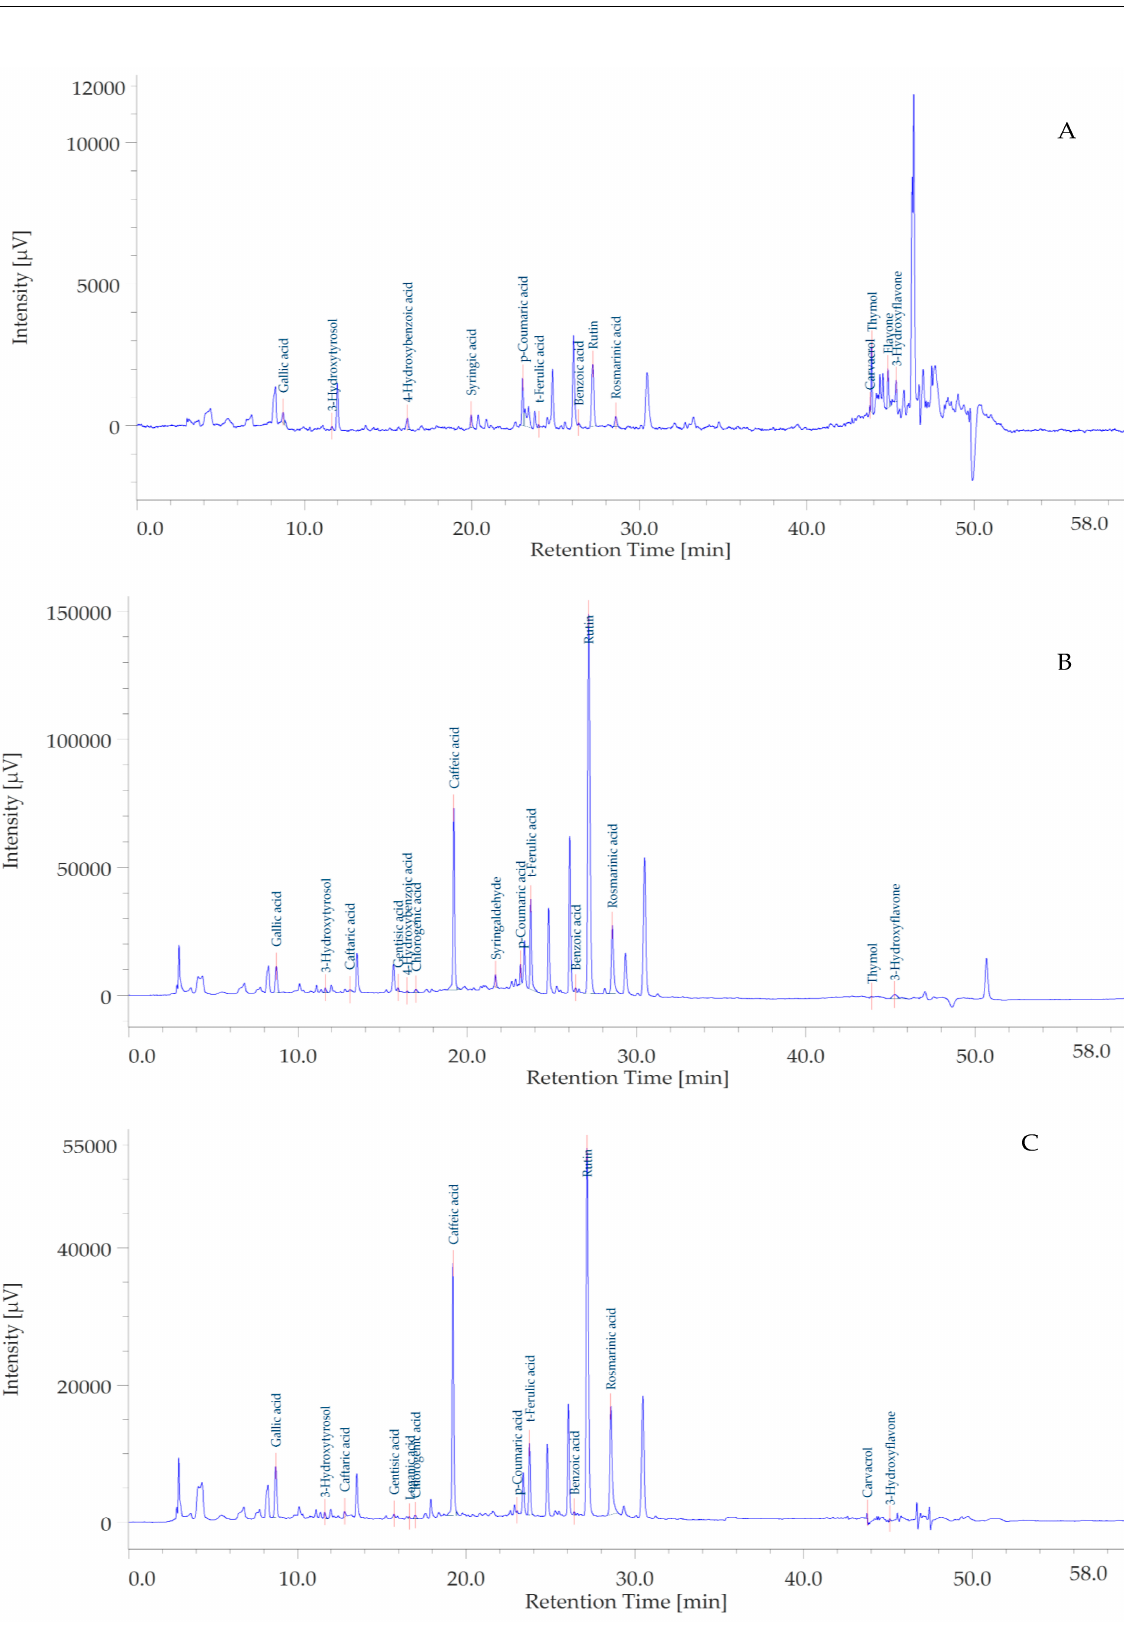
Figure 1. Representative chromatograms of the ethyl acetate ( A ), methanol ( B ), and water ( C ) extracts from the aerial portions of Pelargonium quercetorum. The integration of the present chromatograms has been carried out at 254 nm.